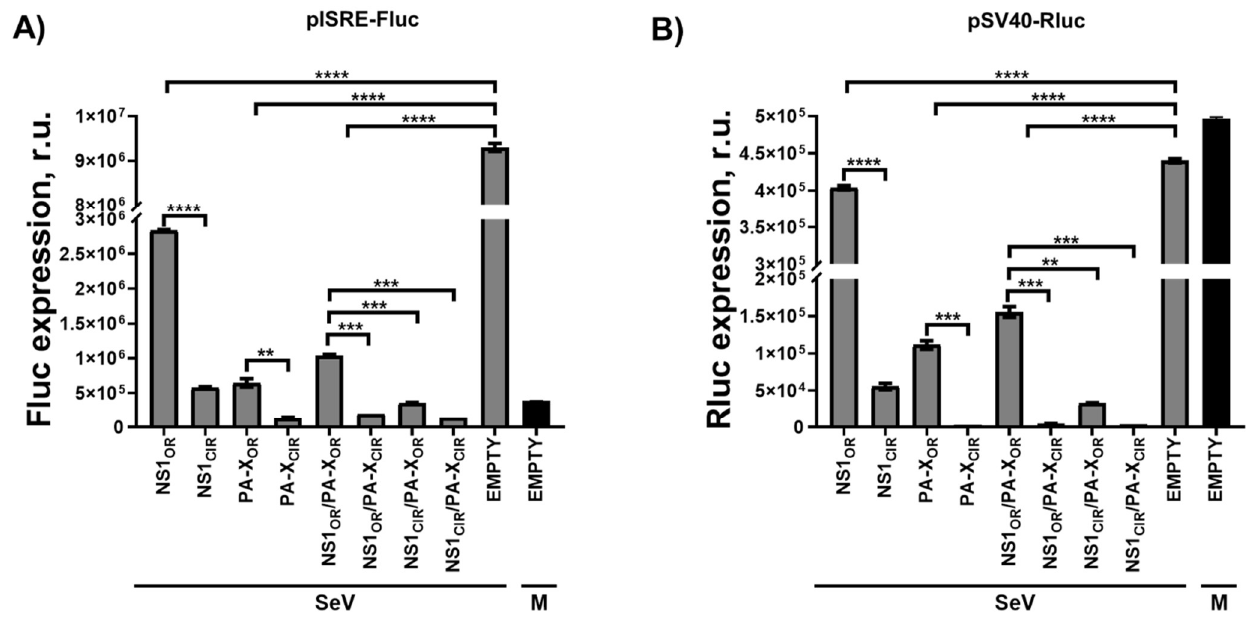
Figure 2. Effect of H5N1 NS1 and PA-X amino acid changes on IFN responses: Human HEK293T cells were transiently co-transfected with a pCAGGS empty plasmid control, or with pCAGGS plasmids expressing the indicated HA epitope-tagged NS1 and PA-X viral proteins, together with a plasmid expressing Fluc under an ISRE dependent promoter, and a plasmid constitutively expressing Rluc. At 24 h p.t, cells were infected with SeV (Cantell strain, MOI 3) or left mock-infected (M), and 20 h later expression of Fluc ( A ) and Rluc ( B ) was analyzed by luminescence. Data show the mean and standard deviations from cells in triplicate. Experiments were repeated 3 times in triplicate, with similar results. *, p < 0.05; **, p < 0.005; ***, p < 0.0005; ****, p < 0.0001 (NS1 OR versus NS1 CIR , PA-X OR versus PA-X CIR , NS1 OR /PA-X OR versus NS1 OR /PA-X CIR , NS1 OR /PA-X OR versus NS1 CIR /PA-X OR , and NS1 OR /PA-X OR versus NS1 CIR /PA-X CIR ) using Student’s t test ( n = 3 per time point). R.u., relative units.